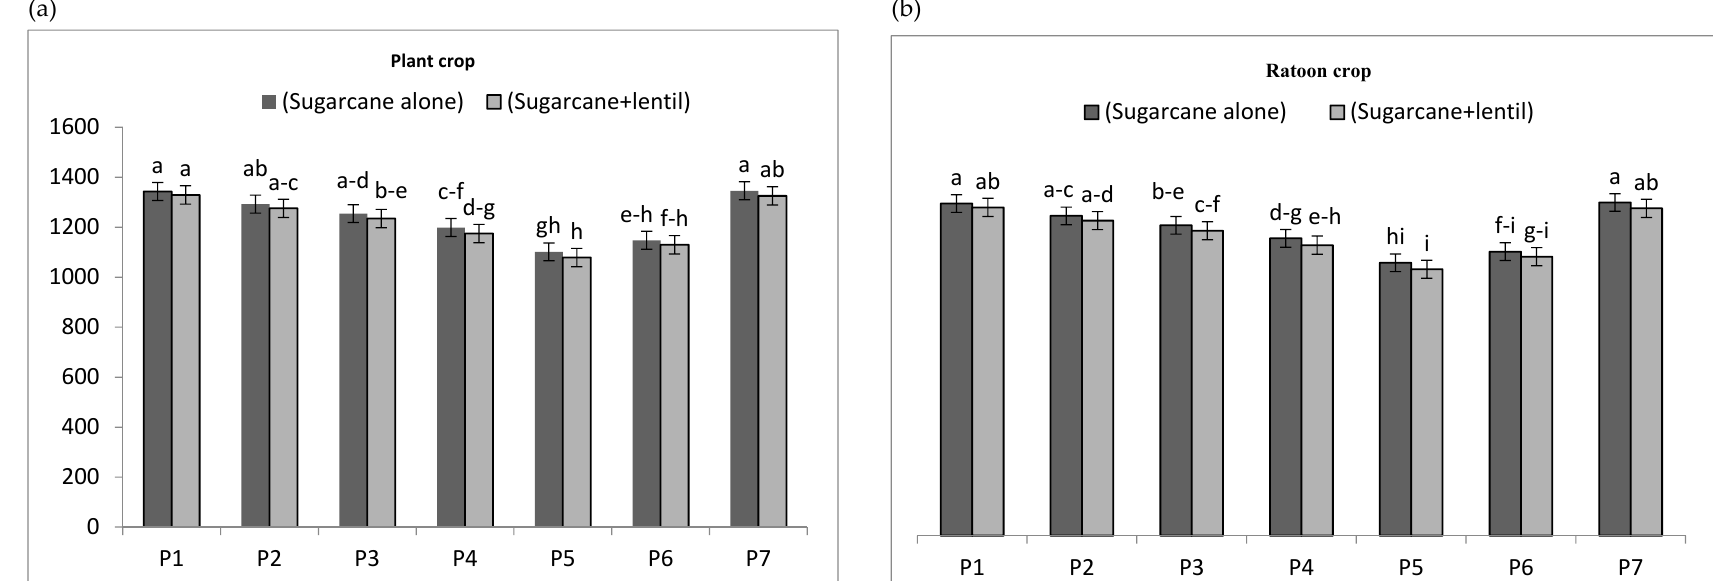
Figure 4. Leaf Area Duration (Days) of sugarcane as influenced by various planting patterns and lentil intercropping in (a) Plant crop and (b) ratoon crop. P 1 : 45 cm pits with 90 cm diameter, P 2 : 60 cm pits with 90 cm diameter, P 3 : 75 cm pits with 90 cm diameter, P 4 : 90 cm pits with 90 cm diameter, P 5 : 60 cm single rows planting, P 6 : 90 cm double rows planting, P 7 : Trench planting at 120 cm. Any two means not sharing a common letter(s) differ significantly at 5% probability.